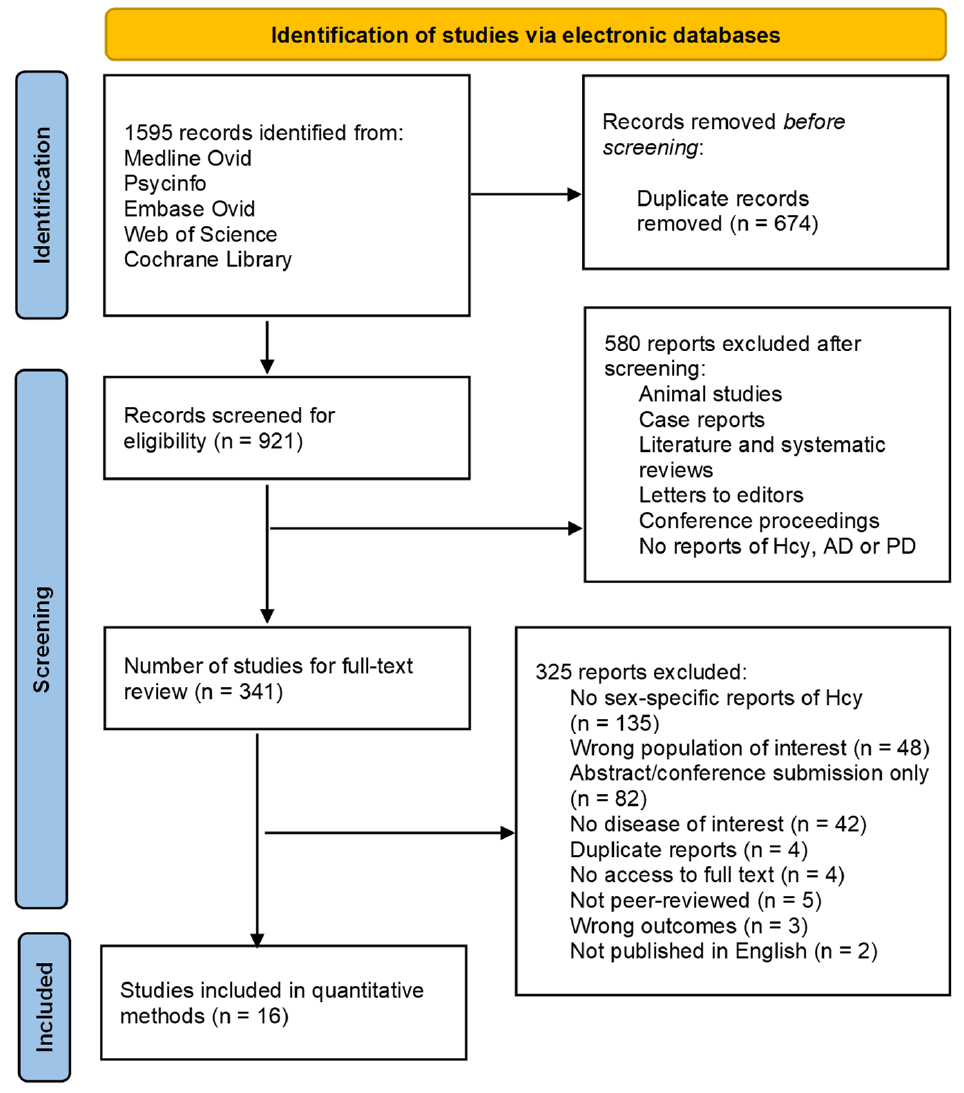
Figure 1. Inclusion and exclusion of studies guided by The Preferred Reporting for Systematic Reviews and Meta-Analyses (PRISMA).